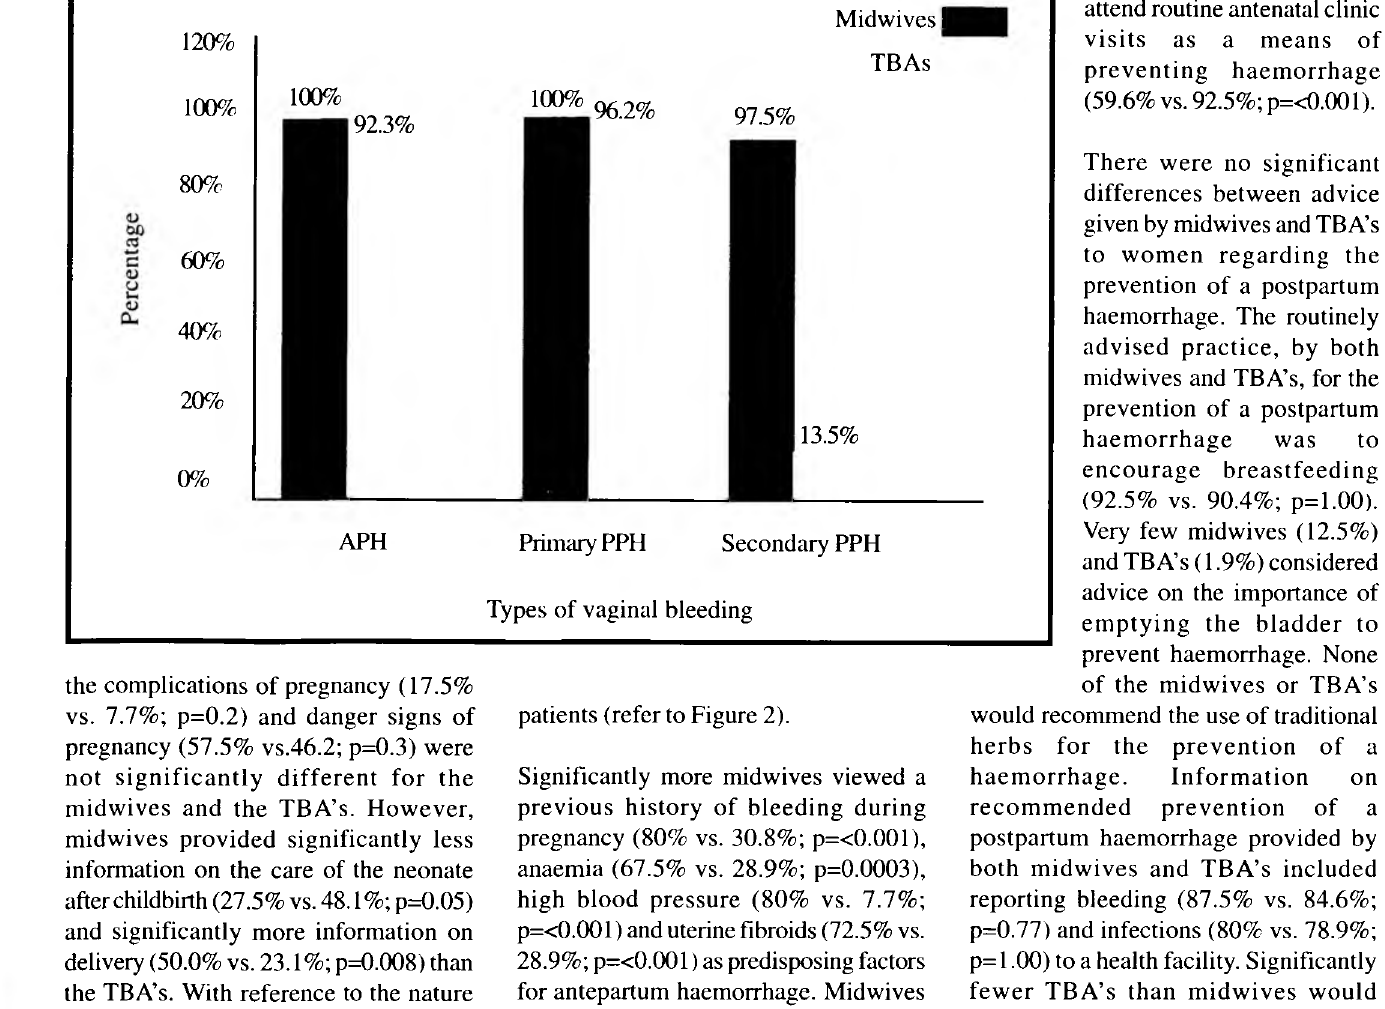
Figure 2 Types of vaginal bleeding included in the